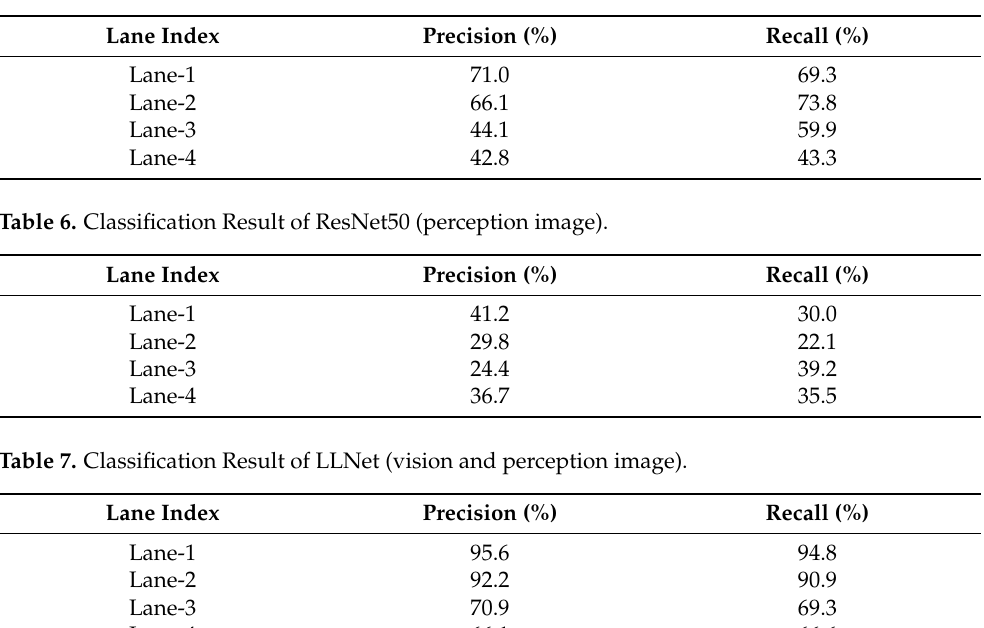
Table 5. Classification Result of ResNet50 (vision image).